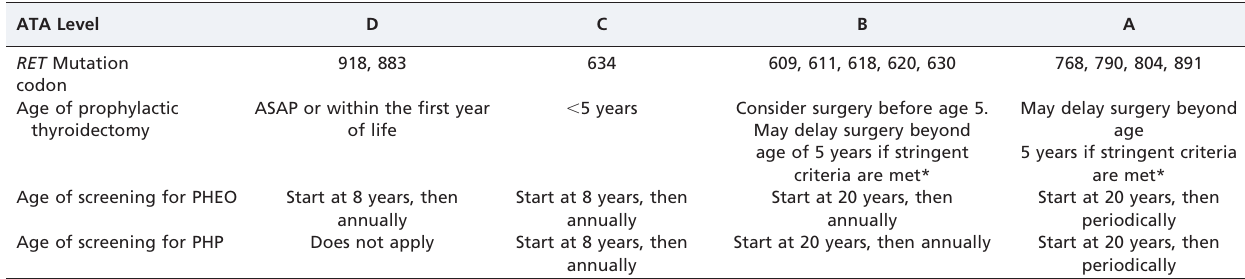
Table 4 - Recommendations for screening procedures and time of prophylactic thyroidectomy. Adapted from (12,13). ATA